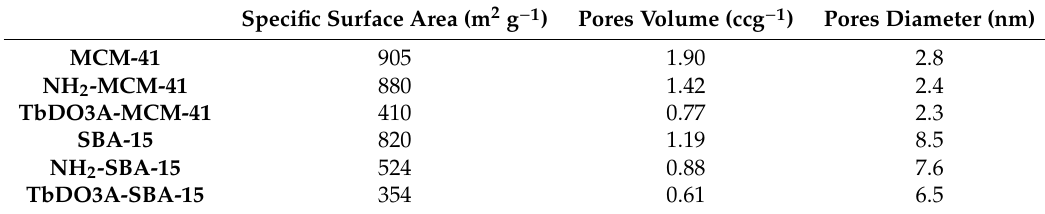
Figure 3. Pore-diameter distribution of MCM-41 ( A , - ● -), NH 2 -MCM-41( A , - ○ -), TbDO3A-MCM-41 ( A , - (cid:7) -), SBA-15 ( B , - • -), NH 2 -SBA-15 ( B , - -) and TbDO3A-SBA-15 ( B , - (cid:7) -). (cid:35) Table 1. Textural properties of all the solids. The specific surface area (SSA) was estimated by BET method and the total pores volume and diameters were determined by Barret–Joyner–Halenda (BJH) approach (applied to the desorption branch), for MCM-41 derivative samples, and by Non Localized Density Functional Theory (NLDFT) method for SBA-15 and functionalized systems.